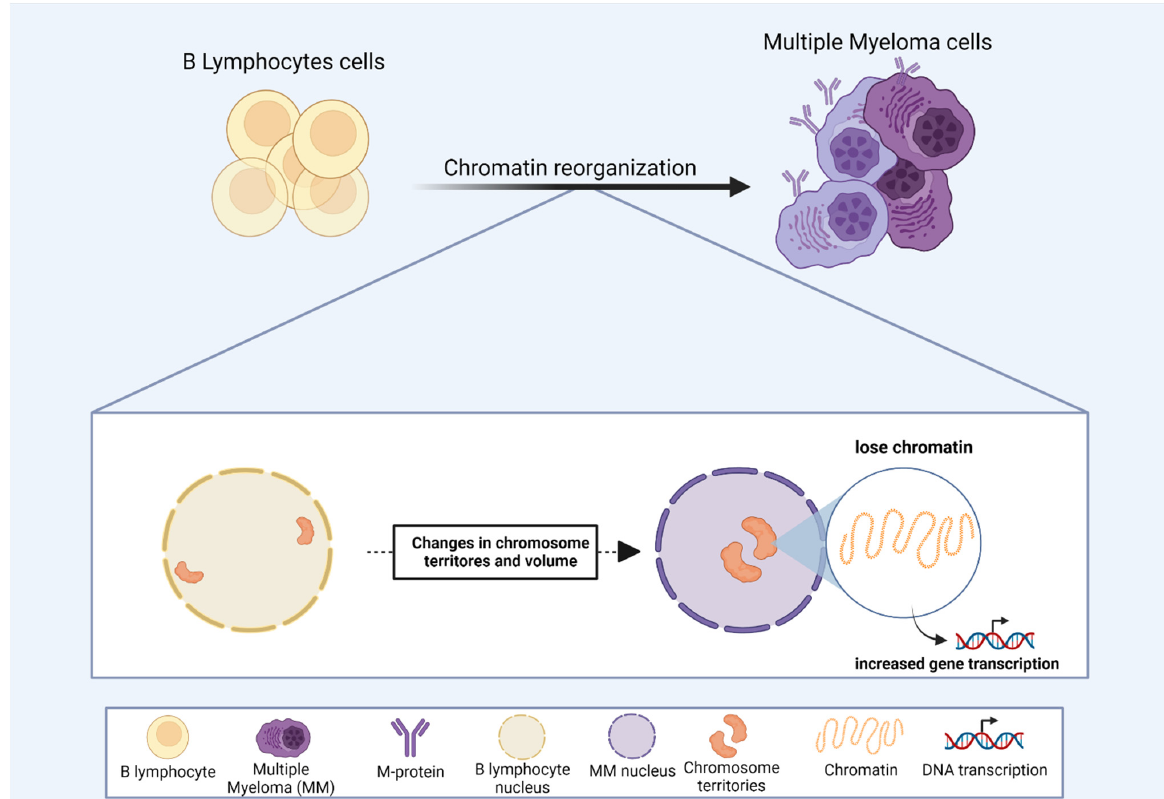
Figure 3. The role of chromosome territories in multiple myeloma (MM). Correlation of chromosome position and chromatin state as drivers of the malignant progression in MM. For details, please see Section 3.1. In MM, some chromosomes display altered positions, towards the nuclear center, compared to regular B lymphocytes. Some chromosome territory volumes also increase in MM, and changes in nuclear organization may favor MM progression by modulating gene